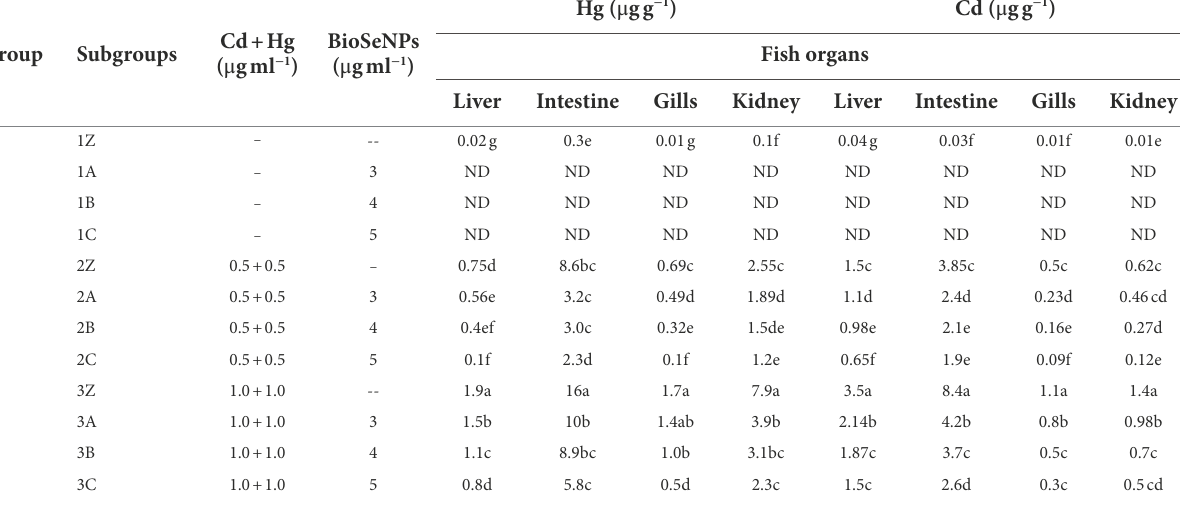
Means in the same column with lowercase different letters are significantly different at p ≤